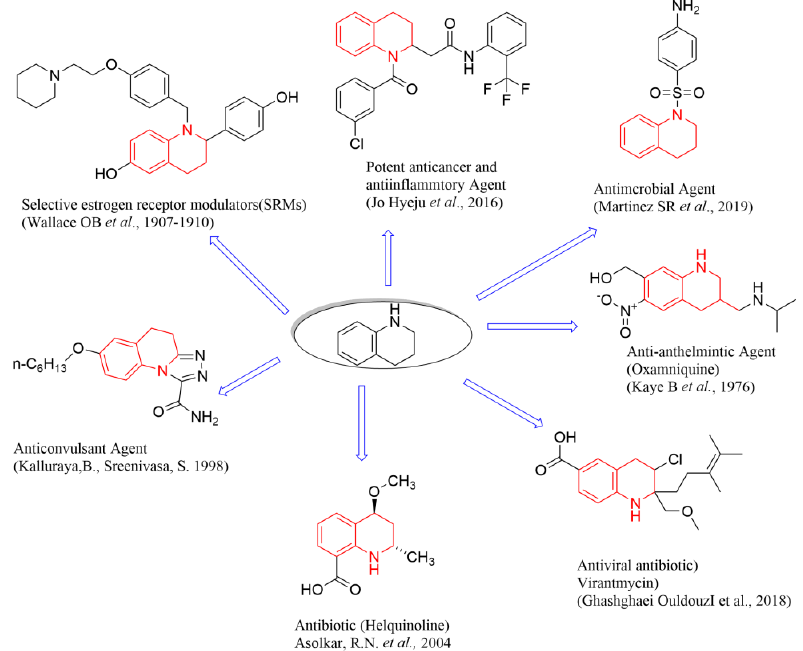
Figure 2. Selected examples of a promising tetrahydroquinoline ring system containing derivatives and their pharmacological activities.